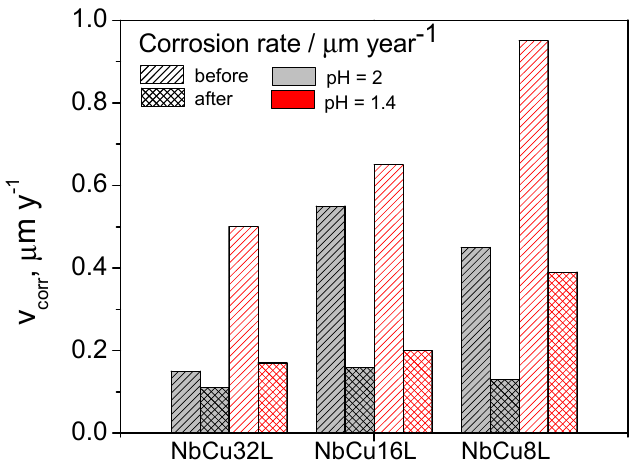
Figure 4. Comparison of corrosion rates of Nb coatings on Cu at pH = 2 and pH = 1.4, before and after polarization at 2 V for 6 h.